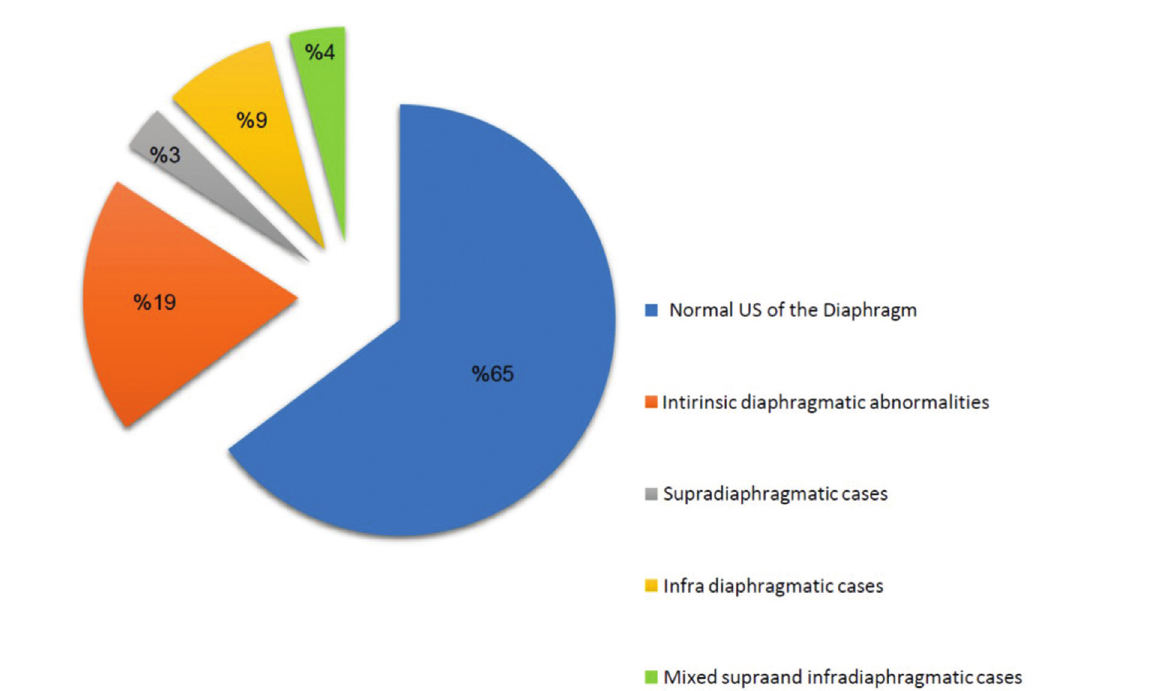
Patients ’ classification regarding ultrasound